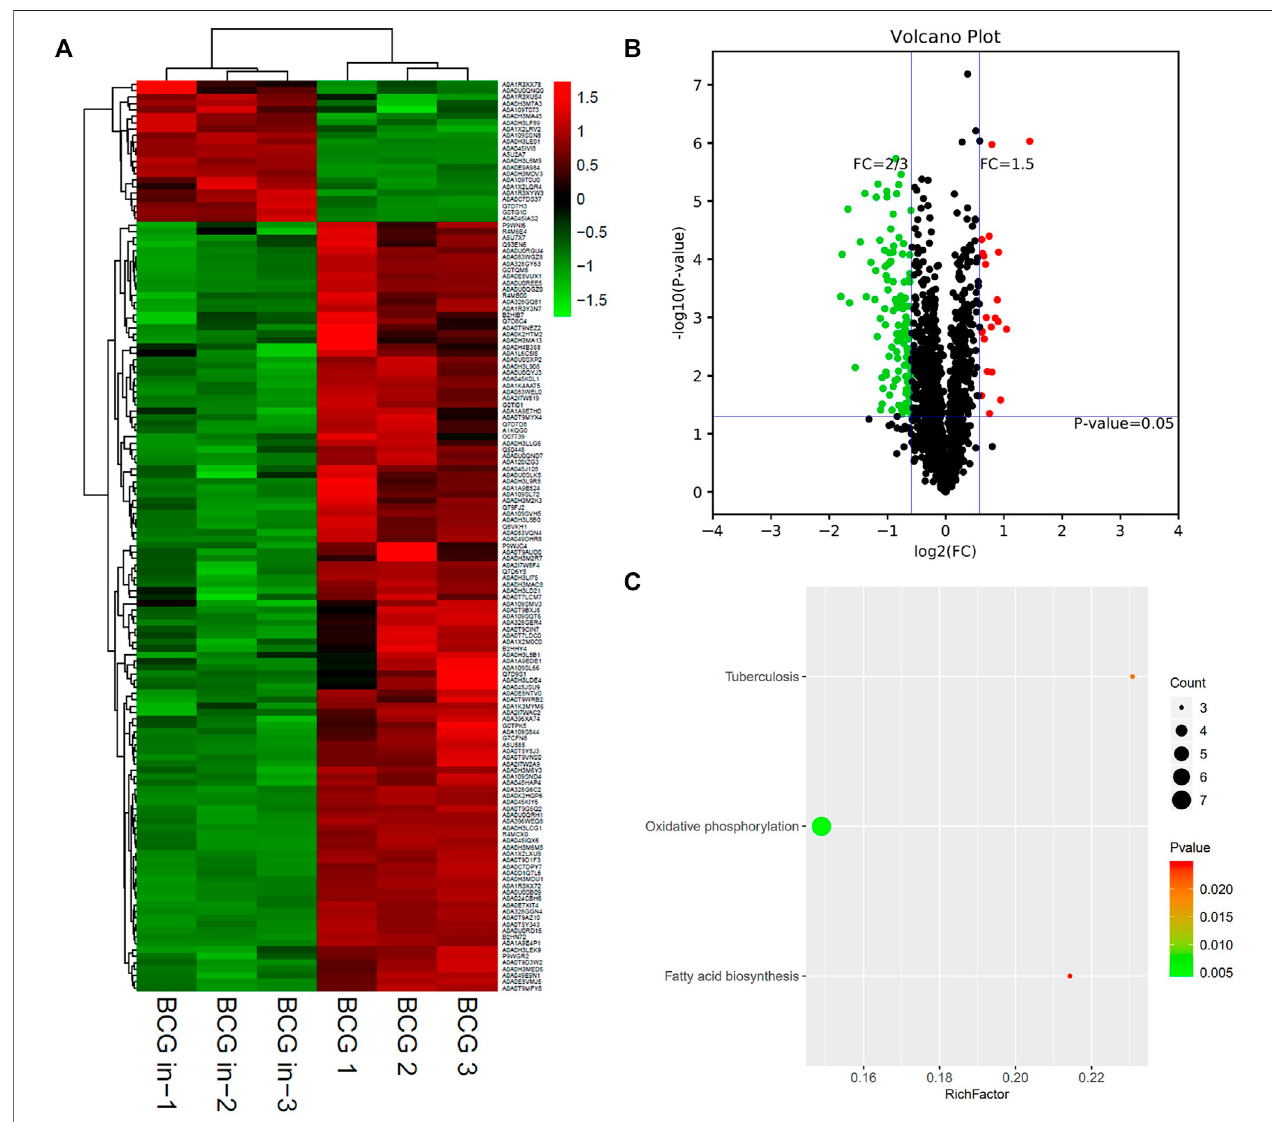
FIGURE 7 | Different protein pro fi le between intracellular BCG and extracellular BCG. (A) Heatmap of proteins differentially expressed between the group of intracellular BCG and extracellular BCG. Green-to-red scale indicates low-to-high proteins expression levels ( p < 0.05). (B) Volcano plots of proteins differentially expressed between the group of intracellular BCG and extracellular BCG. The red dots on the right indicate the signi fi cantly upregulated proteins, whereas the downregulatedareshown withgreen dotsontheleft. Differentiallyexpressed proteins werede fi ned based onathreshold foldchange > 1.5, at p < 0.05. (C) Top10 KEGG pathways (only three in this group) enriched for the signi fi cantly differentially expressed proteins. Entries with larger bubbles contain more differential genes. The color of the bubbles indicates the p value. The smaller the enrichment p value means the greater the degree of signi fi cance ( p <